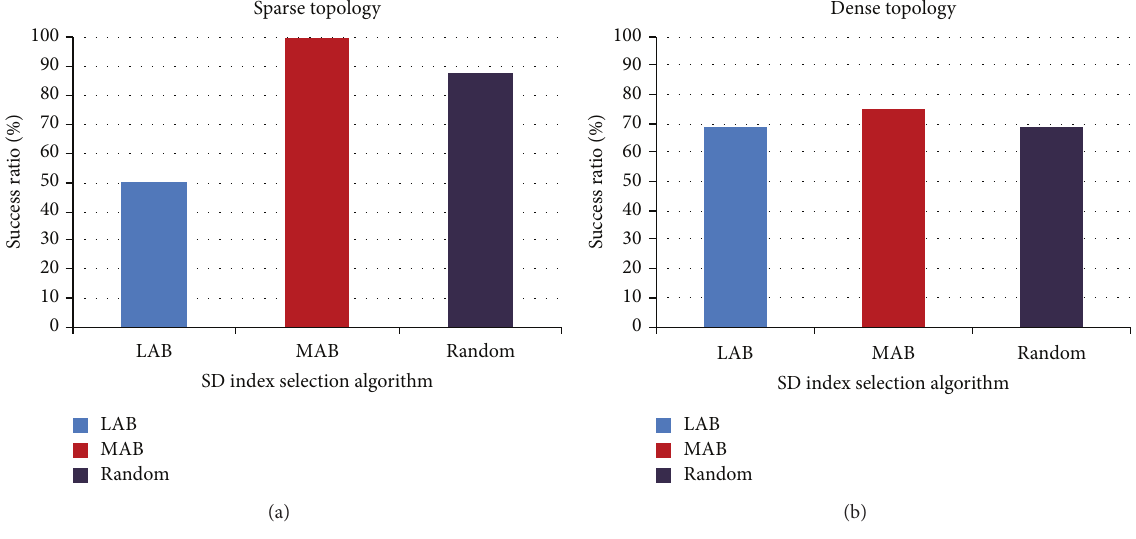
Figure 4: Experiment results of pure DSME beacon